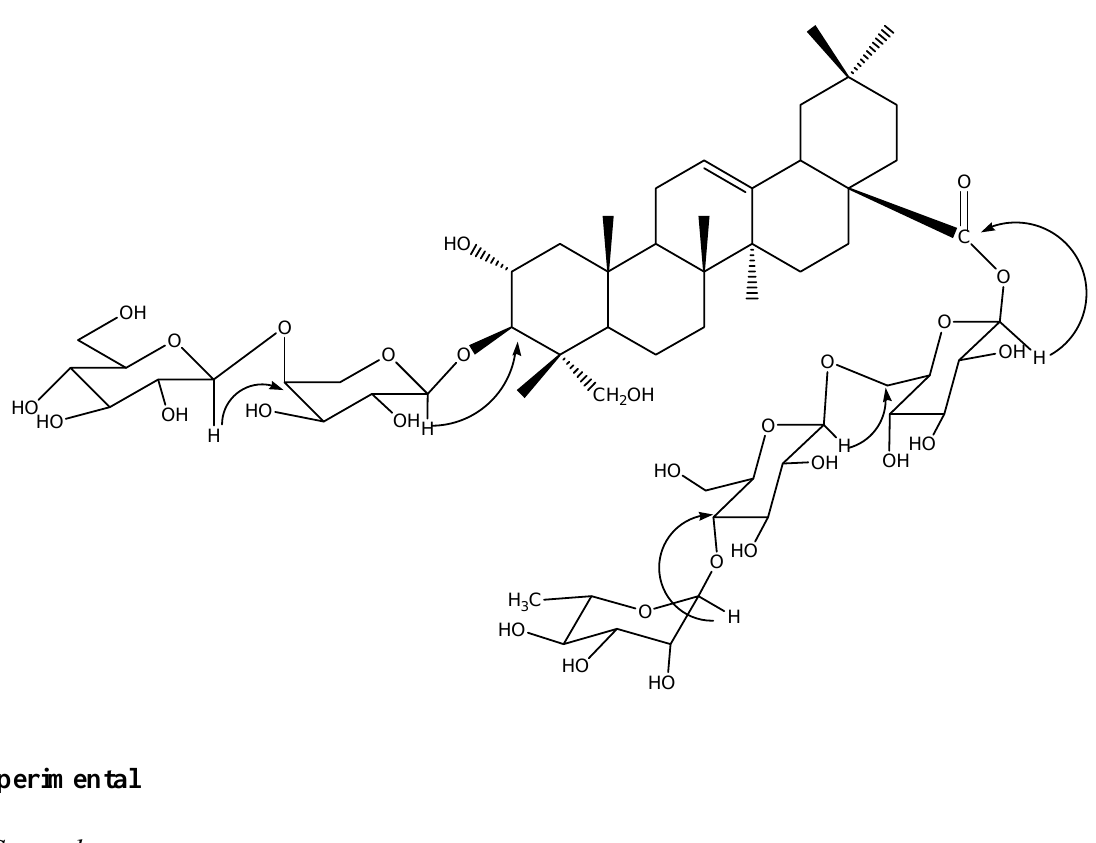
Figure 1. Structure and key HMBC correlations (H → C) of compound 1